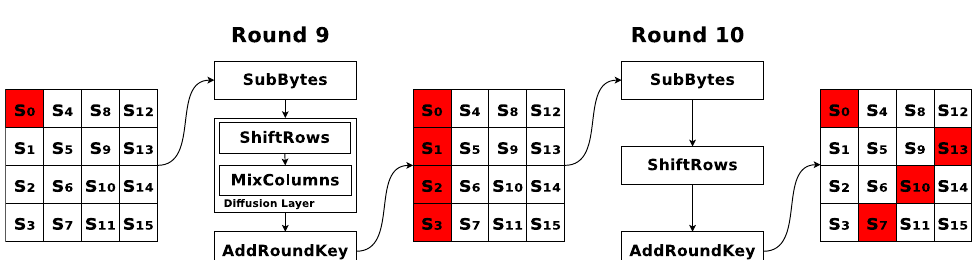
Figure 3: Propagation of a faulty byte in the input of the 9th round of the AES